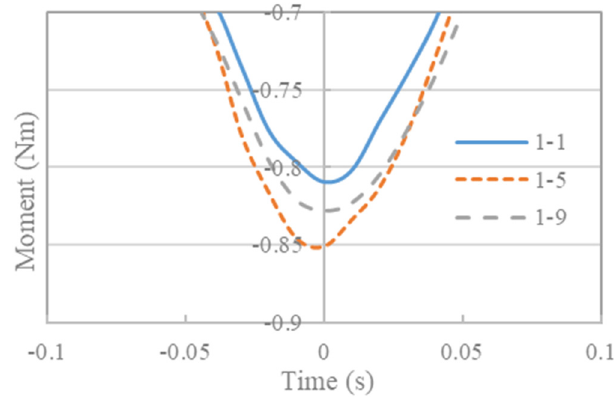
Figure 16. Time history of moment due to contact force.